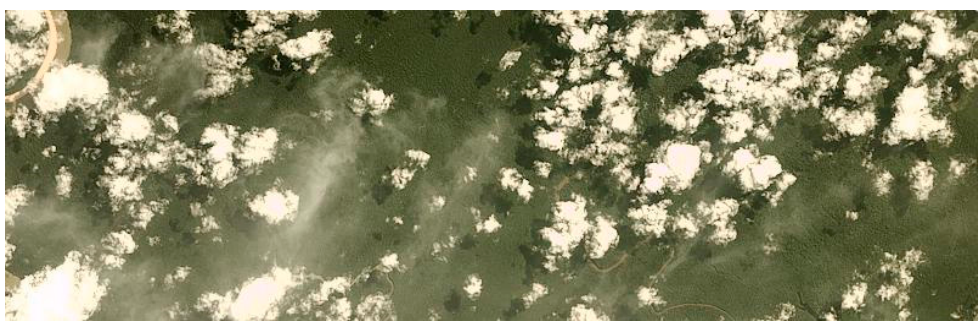
Figure 4. Sample Image Cloudy.